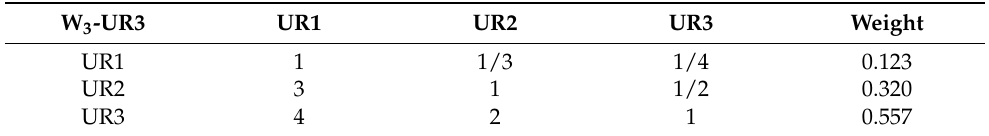
Table A5. Calculating relative weights of URs interms of UR3 through pairwise comparison to determine